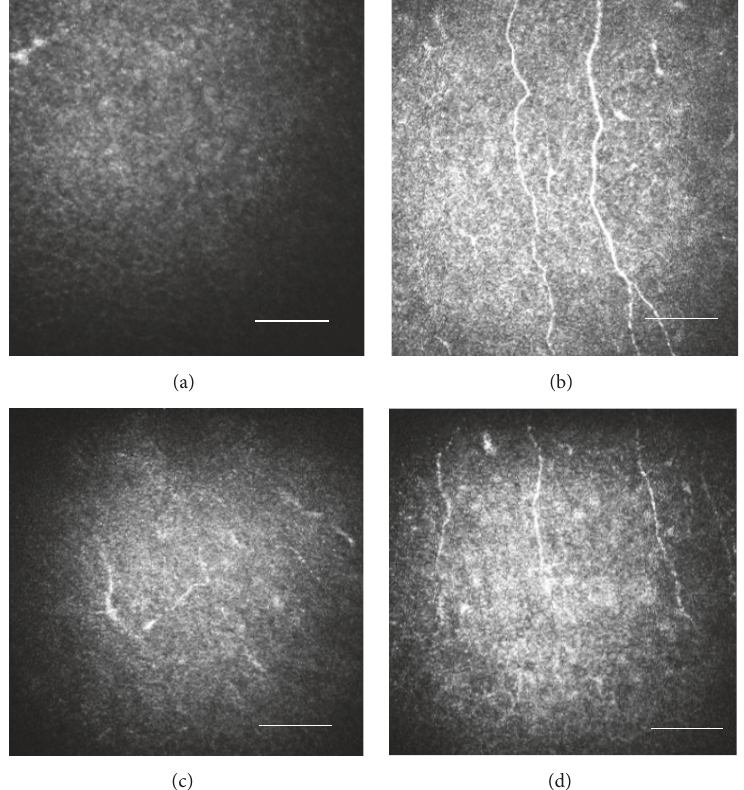
Figure 2: Evaluation of the subbasal nerve fibers in the cornea with the HRT II RCM. Size bar = 100 𝜇 m. (a) Four months after the nerve block, the subbasal nerve fibers were hardly observed in the right eye. (b) Four months after the nerve block, the subbasal nerve fibers were observed in the fellow eye. (c) Six months after the nerve block, regenerated subbasal nerve fibers were observed starting from the periphery of the right cornea, although they appeared small and short. (d) Six months after the nerve block, subbasal nerve fibers were observed in the fellow